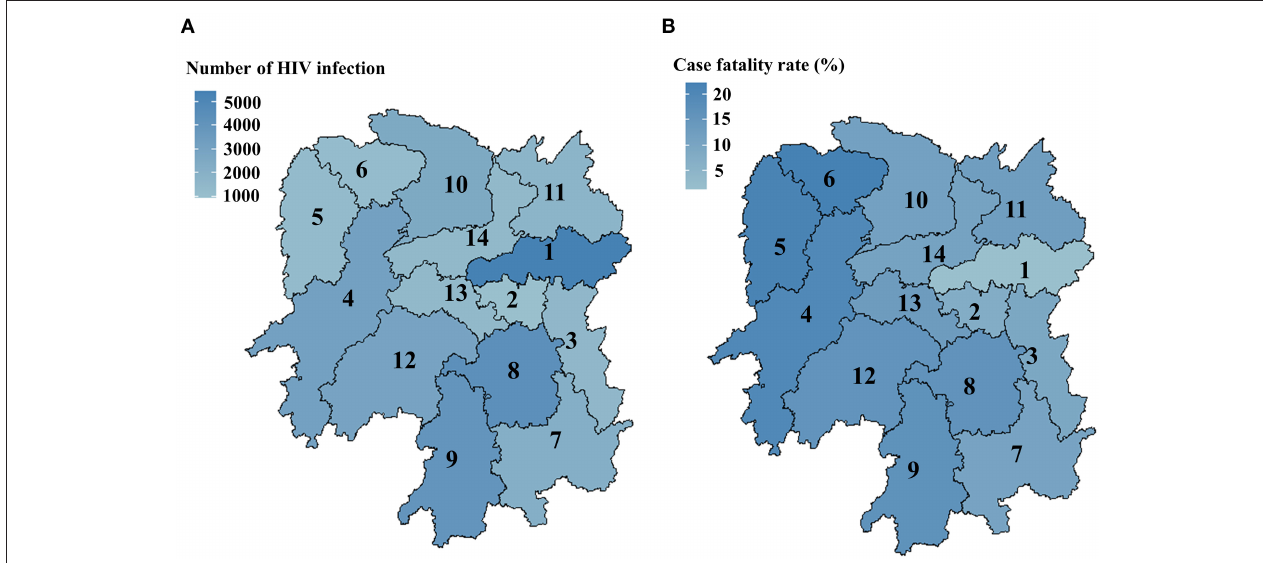
FIGURE 3 | Geographical distribution maps of HIV-1 infections (A) and the case fatality rate (B) in Hunan province from 2003 to 2018. Eastern Hunan included region 1, region 2, and region 3; Western Hunan included region 4, region 5, and region 6; Southern Hunan included region 7, region 8, and region 9; Northern Hunan included region 10 and region 11; Central Hunan included region 12, region 13, and region